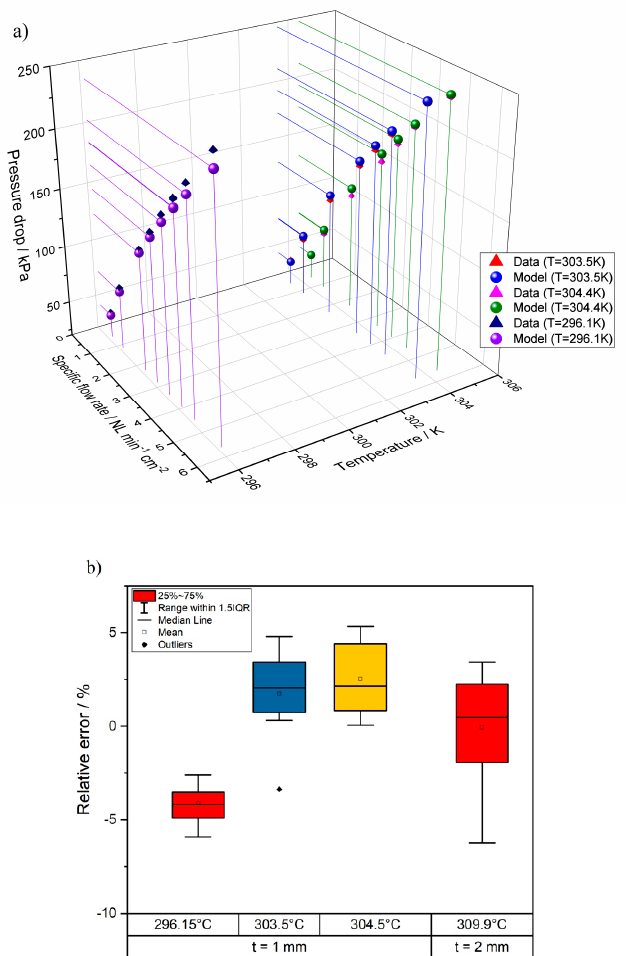
Figure 9. Summary of the support calibration procedure: ( a ) comparison between measured pressure drop data and model predictions for t = 1 mm; ( b ) relative error between data and model for both t = 1 mm and t = 2 mm.